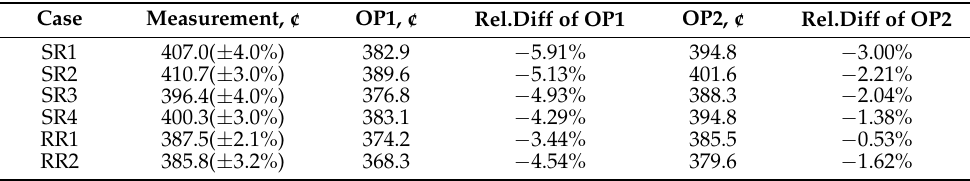
Table 1. Results and comparison of CRW value of JOYO